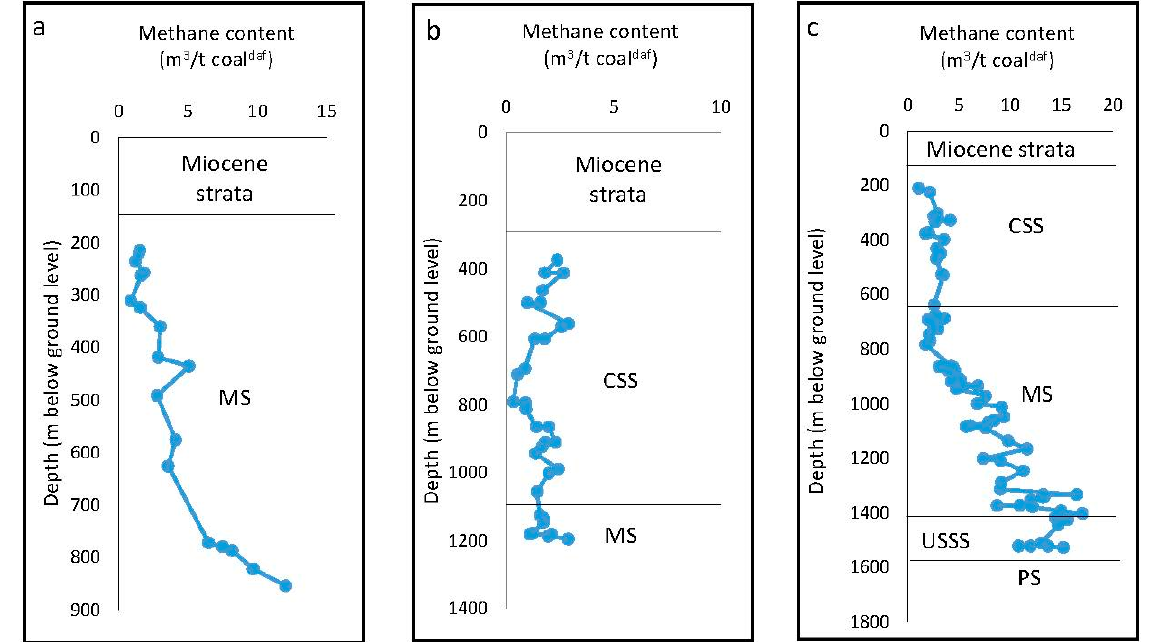
Figure 4. Depth distributions of methane contents in selected boreholes in sub-area 1 ( b ), sub-area 2 ( c ) and north of the study area ( a ). CSS—Cracow Sandstone Series, MS—Mudstone Series, USSS—Upper Silesian Sandstone Series, PS—Paralic Series.